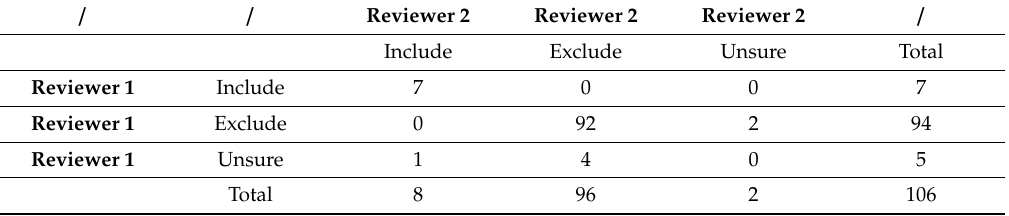
Table 2. K agreement calculation, Po = 0.9339 (proportion of agreement), Pe = 0.809